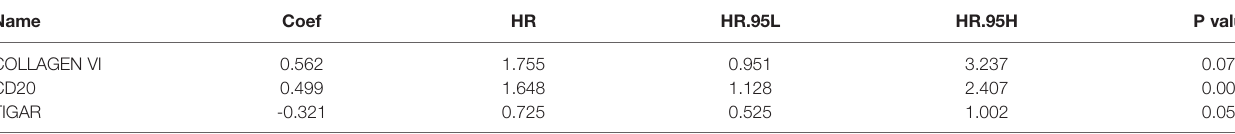
TABLE 2 | Prognostic risk model constructed by R language.